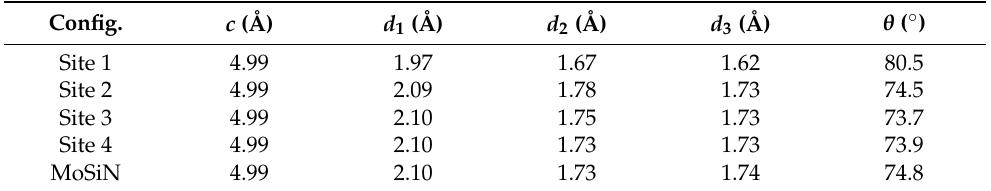
Table 1. The typical structural parameters c , d 1 , d 2 , d 3 , and θ associated with sites 1–4 in pristine aMoSiNNR of n = 4 are compared with those in 2D